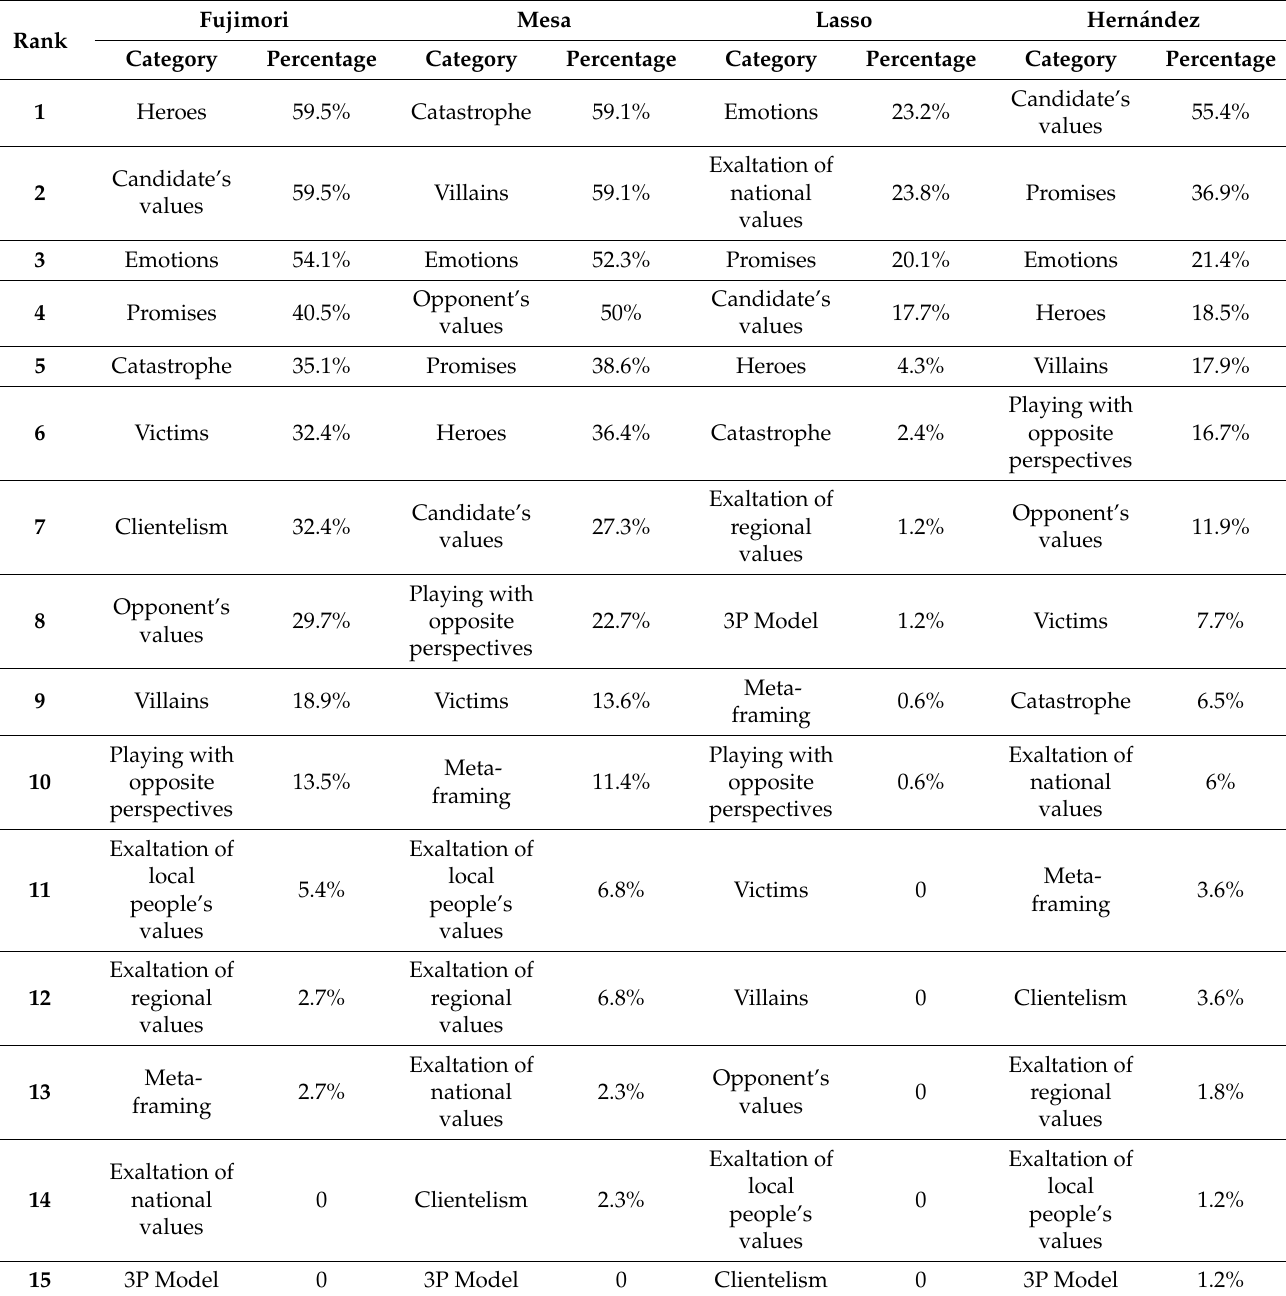
Table 5. Populist categories of right-wing